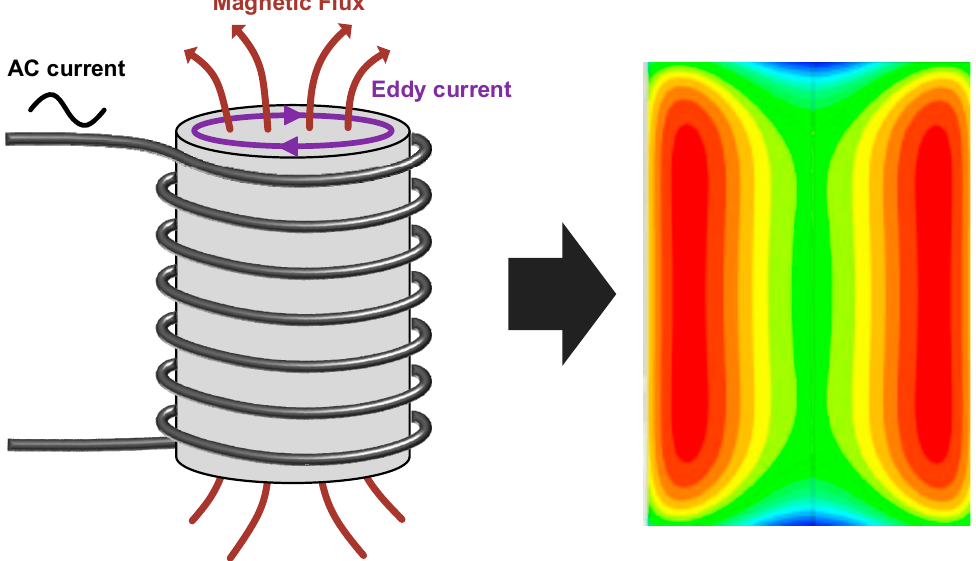
Figure 5. Principle and characteristics of induction heating.